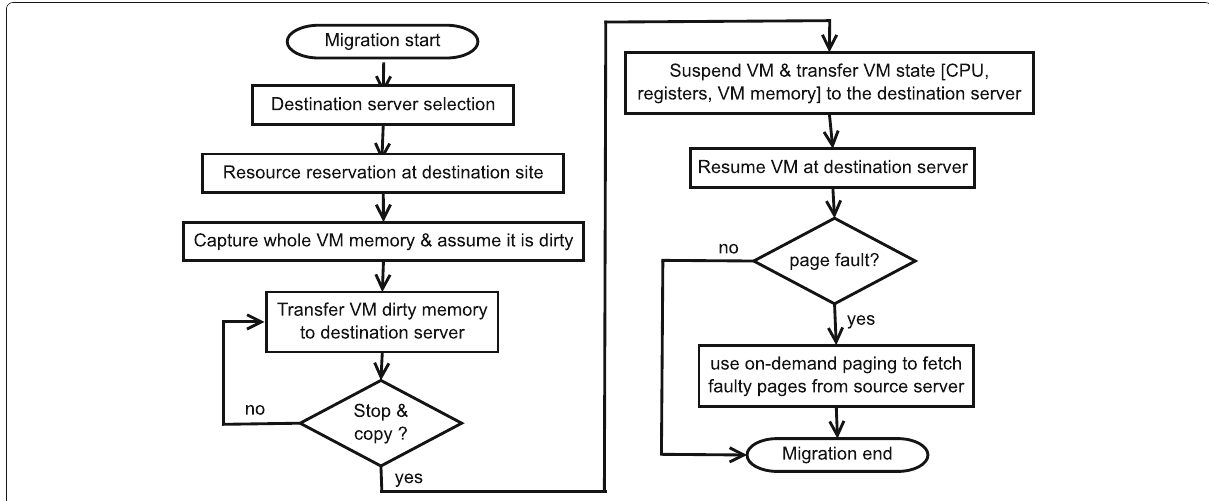
Fig. 4 Basic steps of VM migration follow in hybrid technique